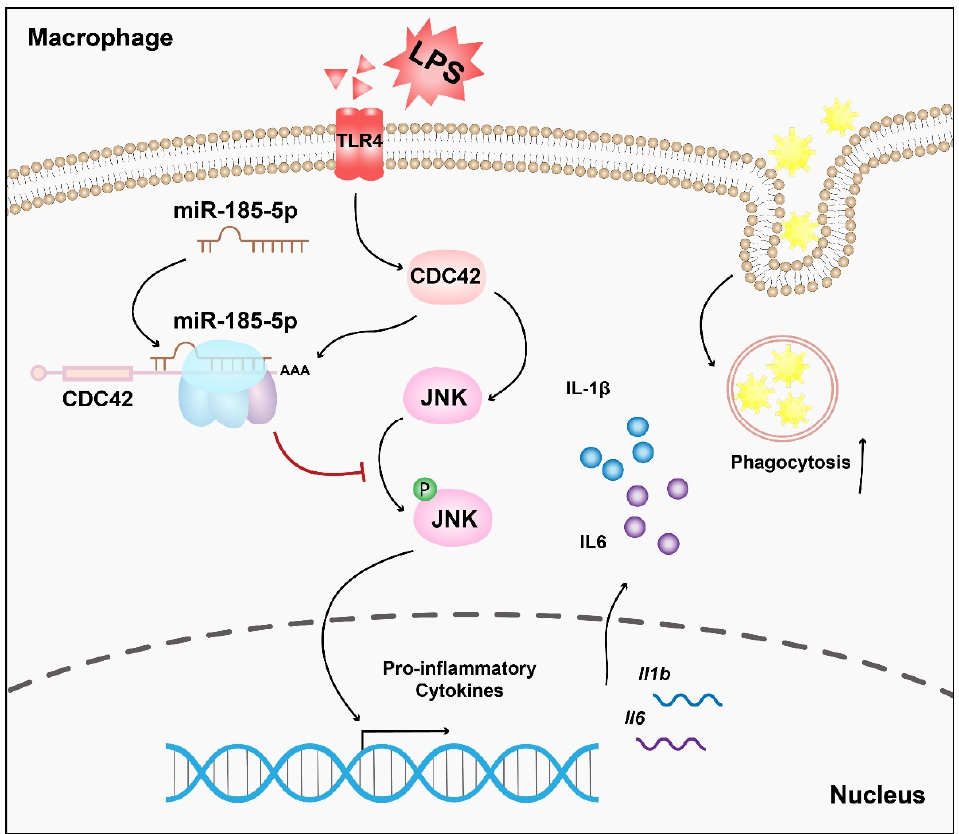
Figure 7. Schematic illustration of the mechanism in which miR-185-5p regulates inflammation and phagocytosis in LPS-induced RAW264.7 macrophages.